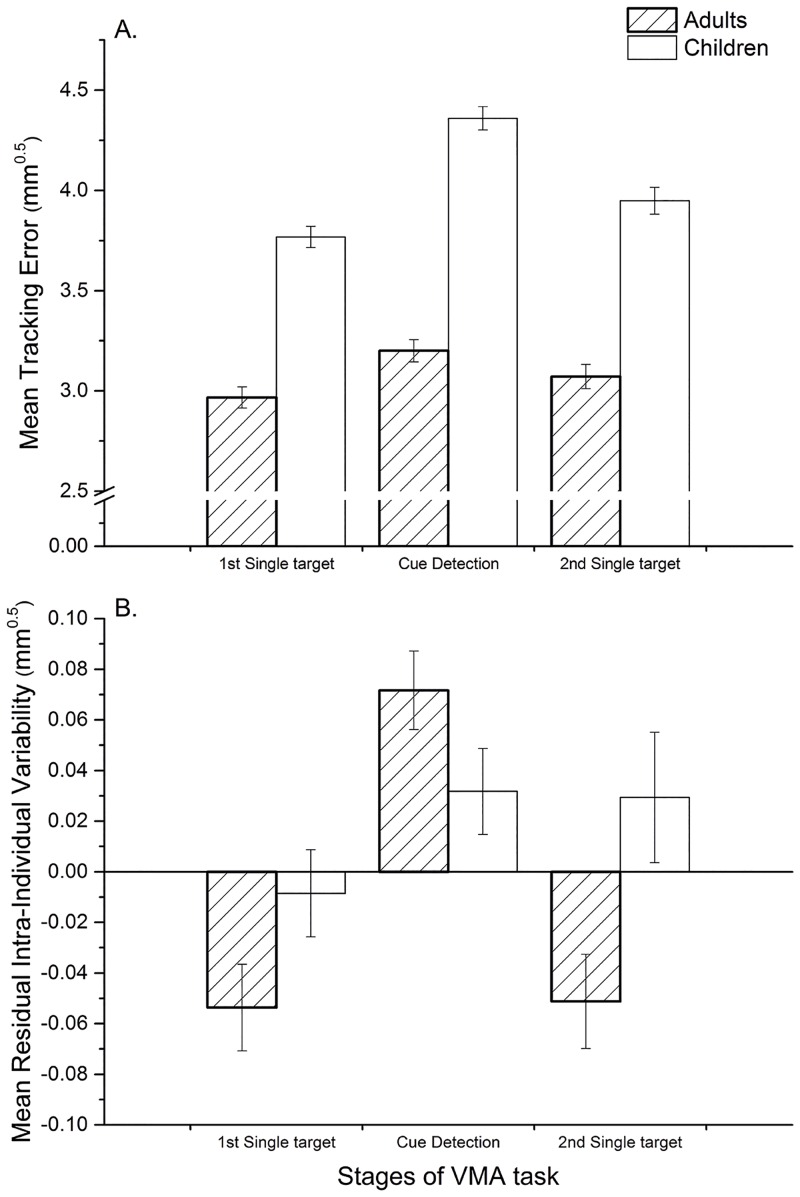
Bar graphs illustrating the significant interaction between age-group and VMA task stage for tracking outcomes in Experiment 2. Panel A: mean tracking error and Panel B: residual intra-individual variability. Error bars represent 95% confidence intervals.